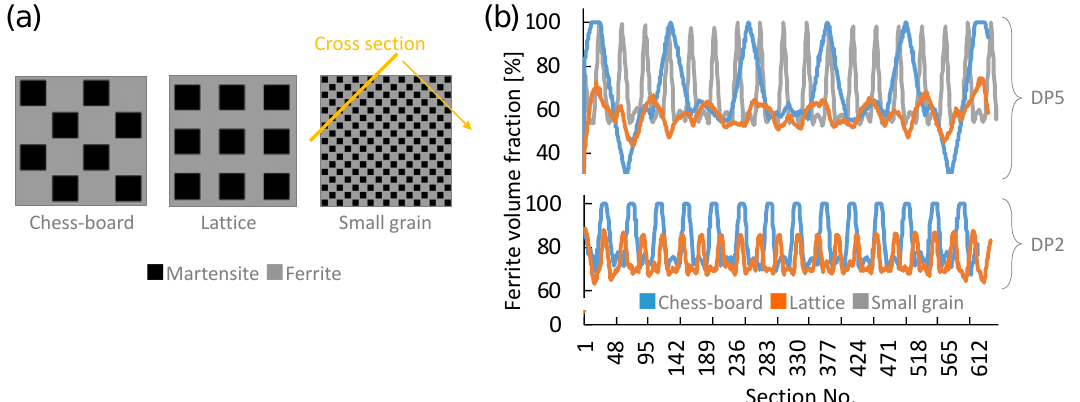
Figure 20. ( a ) Schematic images of three simplified microstructures; and ( b ) ferrite volume fraction of each cross section in those microstructures.